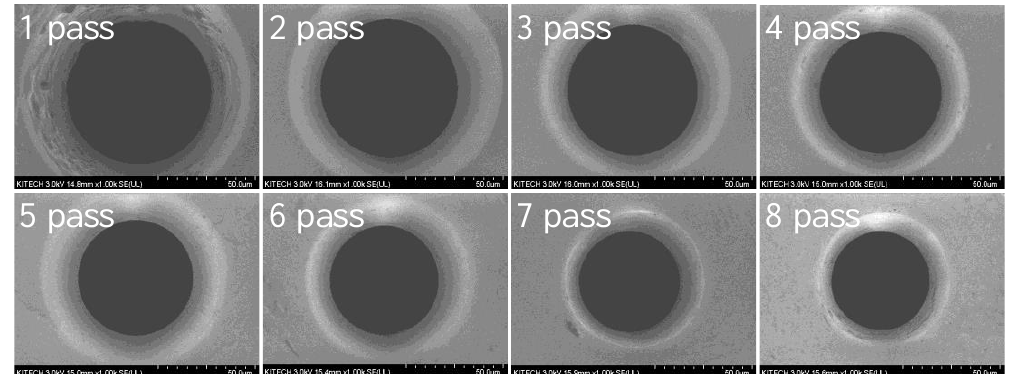
Figure 11. Wire drawing dies.